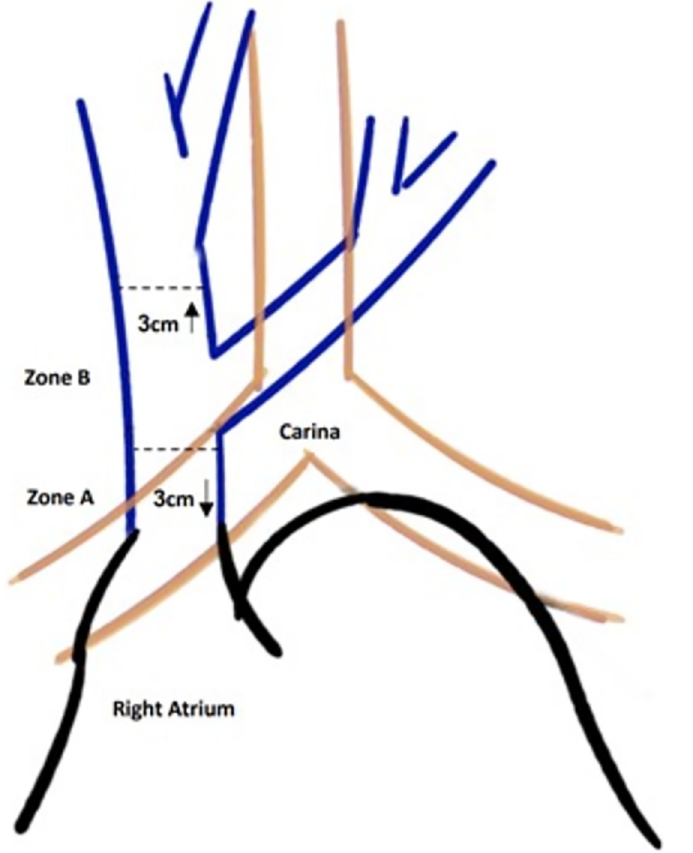
Fig 1. Relationship between the Superior Vena Cava and the